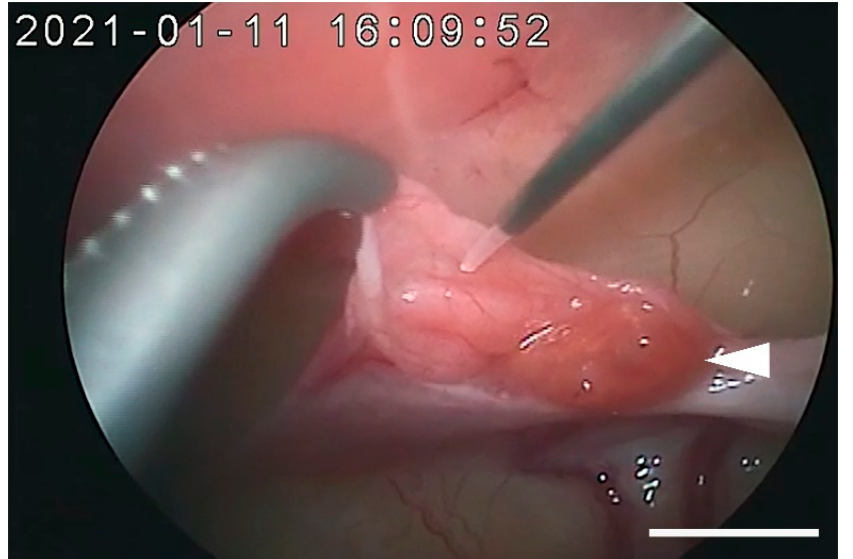
Figure 1. Laparoscopic view of intraoviductal artificial insemination (AI) using the AI needle. The white arrow indicates the position of the left ovary. Bar = 10 mm.